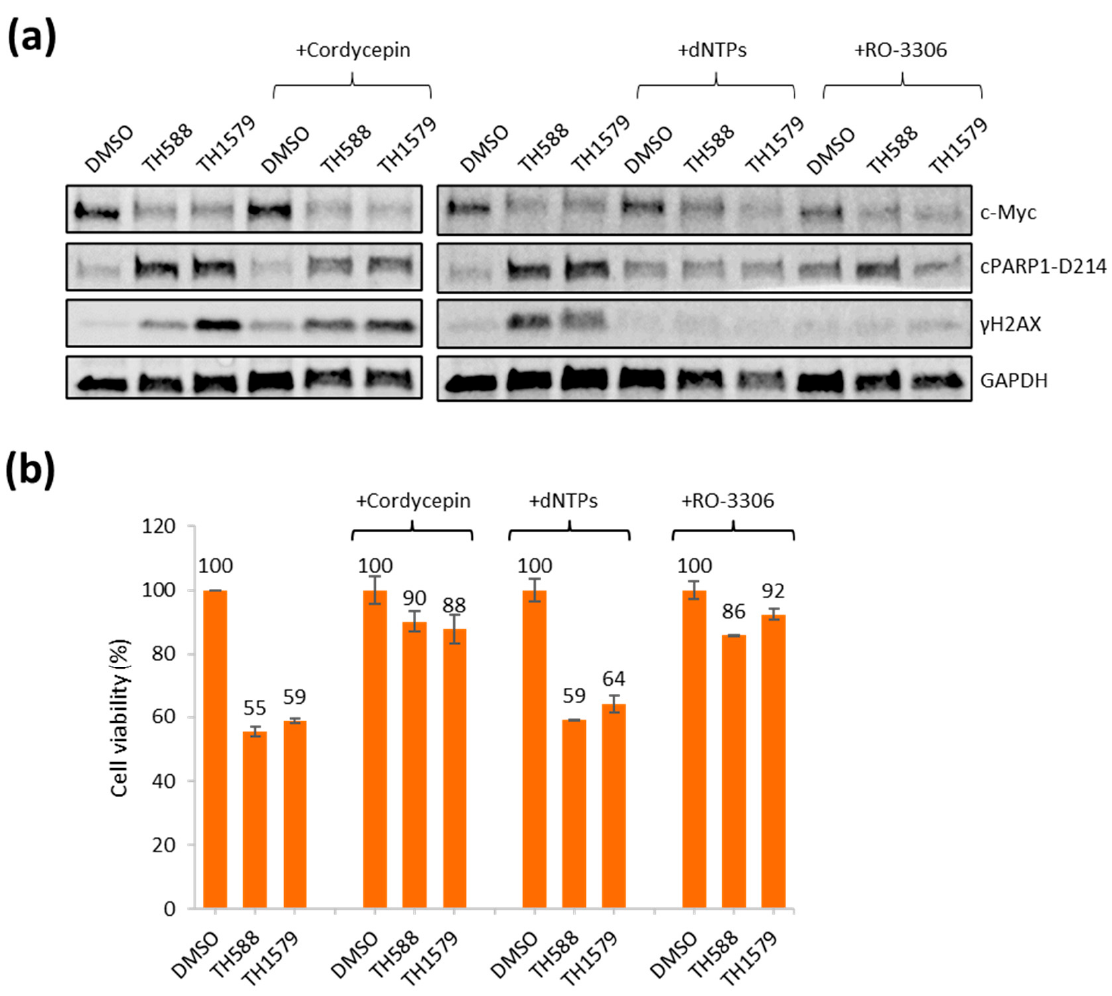
Figure 6. Inhibition of transcription and CDK activity reverse DNA damage and toxicity of mitotic MTH1 inhibitors TH588 and TH1579 in c-Myc overexpressing cells. ( a ) c-Myc-4 cells were treated with 5 µ M TH588 or 0.5 µ M TH1579 for 24 h ± co-addition of cordycepin (50 µ M), nucleosides (dNTPs) (50 µ M) or RO-3306 (5 µ M). The indicated proteins were blotted. ( b ) c-Myc-4 cells were seeded and following 24 h, the cells were treated with 5 µ M TH588 or 0.5 µ M TH1579 for 24 h ± co-addition of cordycepin (50 µ M), nucleosides (dN) (50 µ M) or RO-3306 (5 µ M). Then, 10 µ g/mL resazurin was added for 4 h and viability was determined (values are normalized to internal DMSO control), n = 2 ± S.E.M.